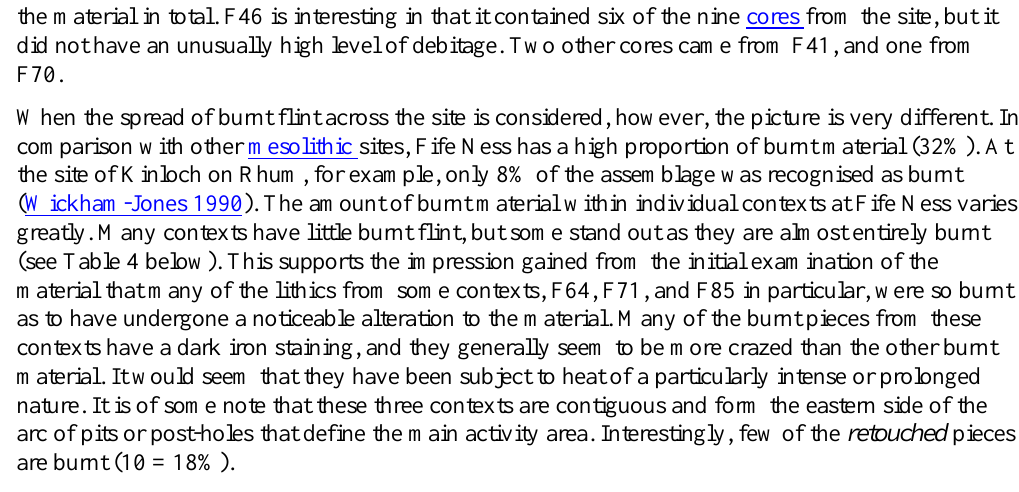
Table 4 : Distribution of burnt pieces amongst the flaked lithic assemblage* * * Context * Fill Of * Total Lithics * % Burnt *F40 F41